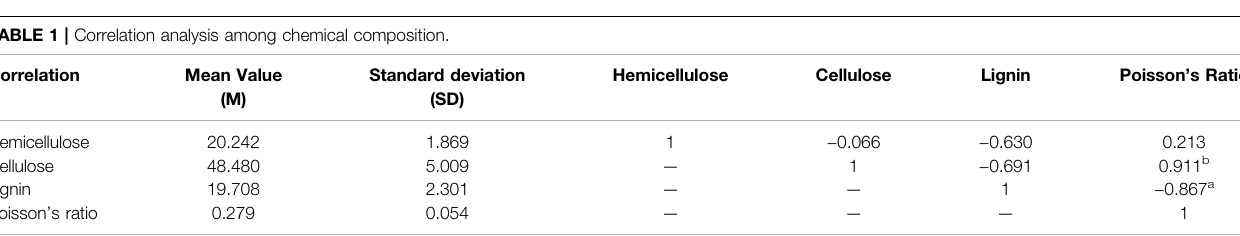
TABLE 1 | Correlation analysis among chemical